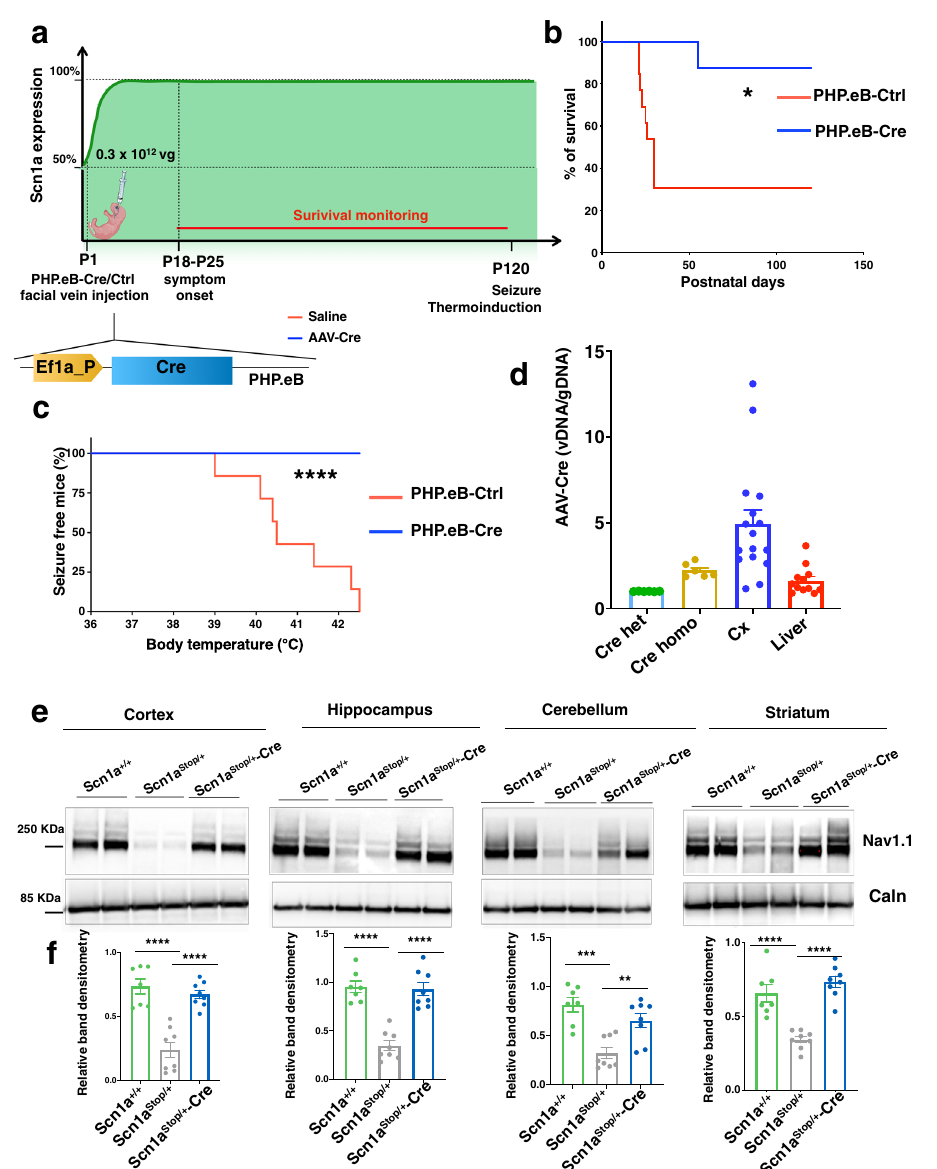
Fig. 2 Perinatal normalization of Na v 1.1 level prevents SUDEP and seizures in DS model. a Schematic representation of the experimental timeline, with Scn1a Stop// + mice undergoing PHP.eB-Ctrl or Cre facial vein injection at P1, followed by survival monitoring and seizure thermal induction at P120. Created with BioRender.com b Survival curve of Scn1a Stop/ + -Ctrl ( n = 13) and Scn1a Stop// + -Cre ( n = 9) mice (* p = 0.0108, Log-rank Mantel-Cox test). c Plot showing the percentage of seizure-free Scn1a Stop/ + -Cre mice compared to Scn1a Stop/ + -Ctrl mice ( n = 7 for each group, **** p < 0.0001; Mantel-Cox log- rank test). d Viral copy number analysis in mice injected with PHP.eB-Cre in the cerebral cortex and liver. e, f Western blot analyses of Na v 1.1 protein in the cortex, hippocampus, cerebellum and striatum in Scn1a + / + , Scn1a Stop/ + - Ctrl and Scn1a Stop/ + - Cre mice and their relative band densitometry quanti fi cation normalized on calnexin, (**** p < 0.0001,*** p = 0.0002, ** p = 0.006, one-way ANOVA with Tukey ’ s multiple comparison). Data are represented as mean ± SEM with dots representing individual samples. Source data are provided as a Source Data fi